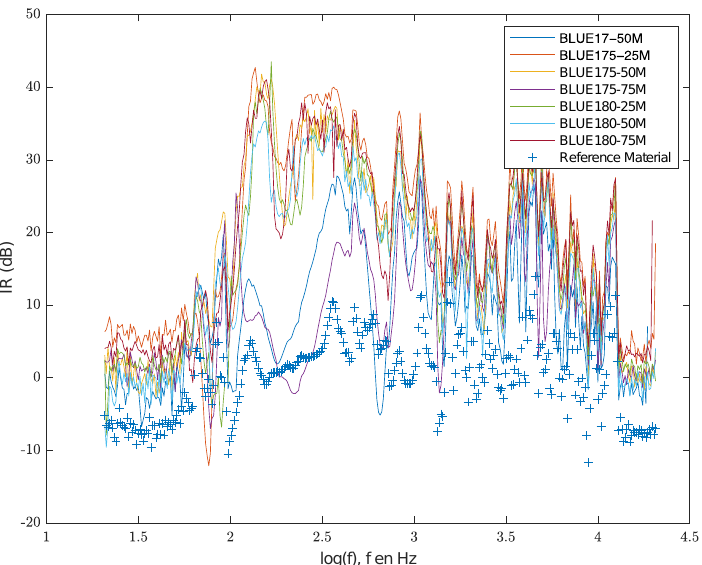
Figure 6. Reduction index of blue briquettes (lines) compared to the reference material (crosses). Volume